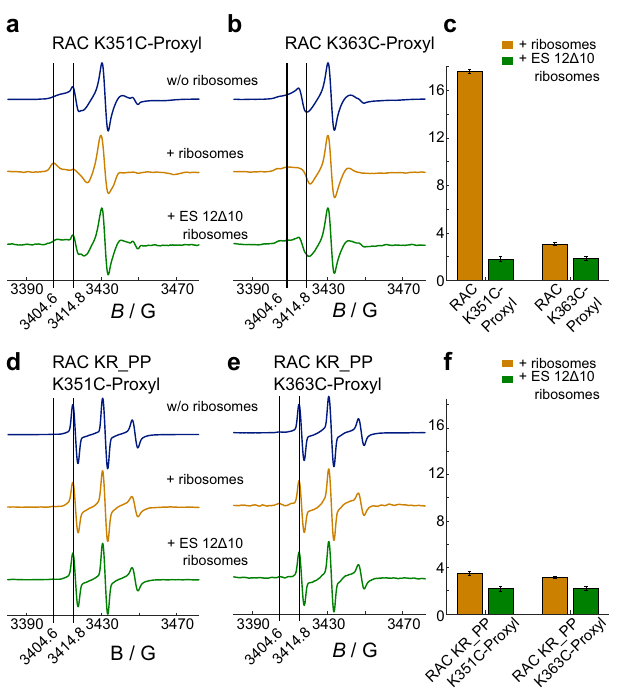
Figure 2. X band EPR spectra of RAC labeled in helix 1 of Zuo1’s 4HB. Shown are the spectra of ( a ) RAC K351C-Proxyl, ( b ) RAC K363C-Proxyl and ( d , e ) the respective variants with two prolines (KR_PP) in absence (blue) or presence of ribosomes (yellow) or ES12Δ10 ribosomes (green). Significant spectral features as represented by low field peaks at 3404.6 G and 3414.8 G are highlighted by a black line. ( c + f ), The intensity ratios at the position of the two low-field peaks (low field peak ratio, LFPR) were calculated for spectra with ribosomes and normalized to the respective ratio in absence of ribosomes. Error bars indicate the noise-low field peak signal ratio.